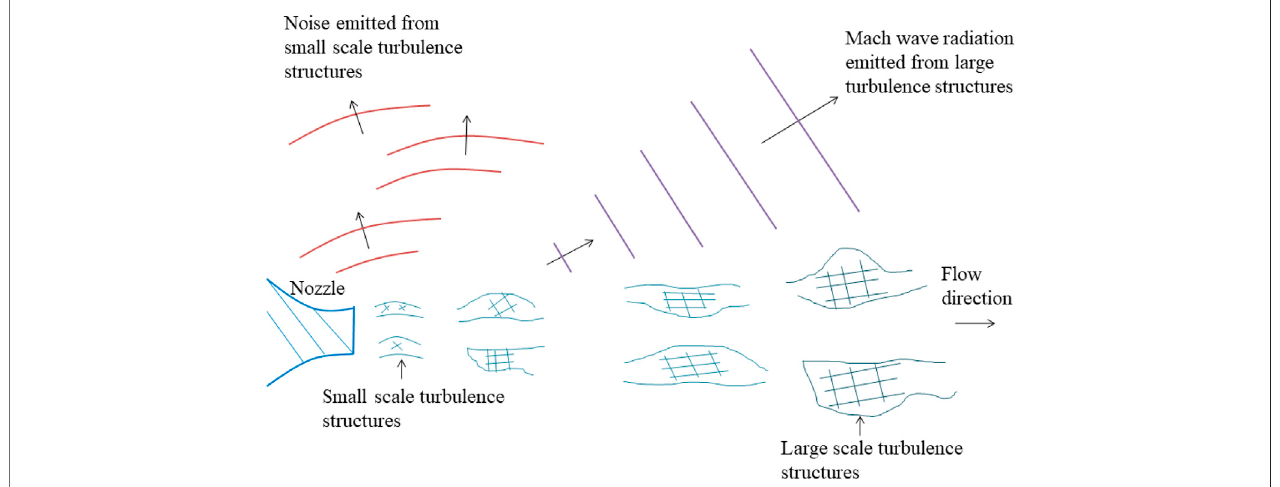
FIGURE 9 | Schematic diagram of noise radiation from small- and large-scale turbulent structures.